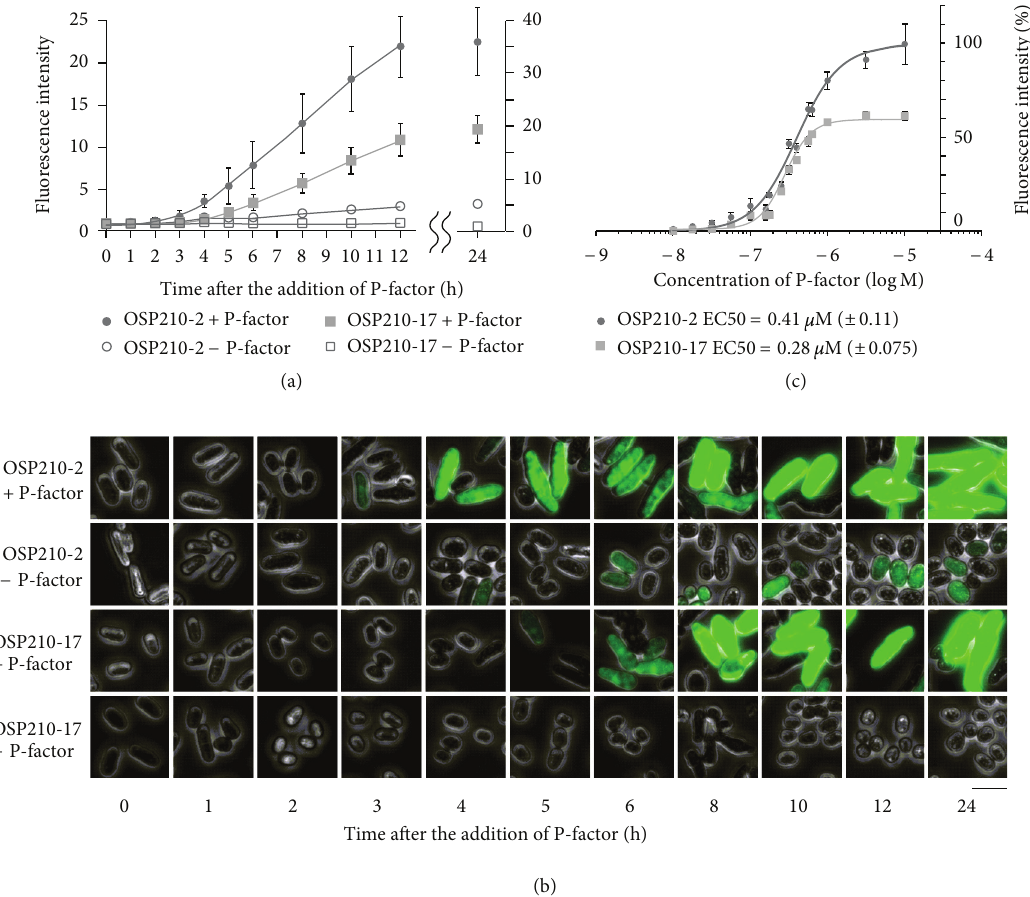
F 2: Time- and dose-dependent response to P-factor with the reporter plasmids. (a) Time-dependent response to P-factor with either pAL7-U mam2 -GFP-LPIorpAL7-U sxa2 -GFP-DSPBC4.01. ecellswereexposedto1or0 MofP-factorandweretakenevery hour(0–6h), two hours (6–12h) or twelve hours (12–24h). Filled circle depicts OSP210-2 ( sxa2 , pAL7-U mam2 -GFP-LPI) +P-factor, open circle depicts OSP210-2 P-factor, �lled square depicts OSP210-17 ( sxa2 , pAL7-U sxa2 -GFP-DSPBC4.01) +P-factor and open square depicts OSP210-17 𝜇𝜇 P-factor. e values were the means of triplicate determinations from a typical experiment. e error bars represent standard error. (b) Δ Aliquots of culture medium (2 L) were mounted on slides and visuali�ed by a �uorescence microscope. Aer the addition of P-factor, the − Δ morphology was gradually changed and the production of GFP increased. Scale bar = 10 m, (c) dose-dependent response. e cells were − ± exposed to the various concentrations of P-factor and were incubated for 24 hours aer the addition of P-factor. Filled circle depicts OSP210-2 𝜇𝜇 ( sxa2 , pAL7-U mam2 -GFP-LPI) and �lled square depicts OSP210-17 ( sxa2 , pAL7-U sxa2 -GFP-DSPBC4.01). -axis denotes a percentage 𝜇𝜇 of the maximum response. e values were the means of triplicate determinations from a typical Δ Δ 𝑌𝑌